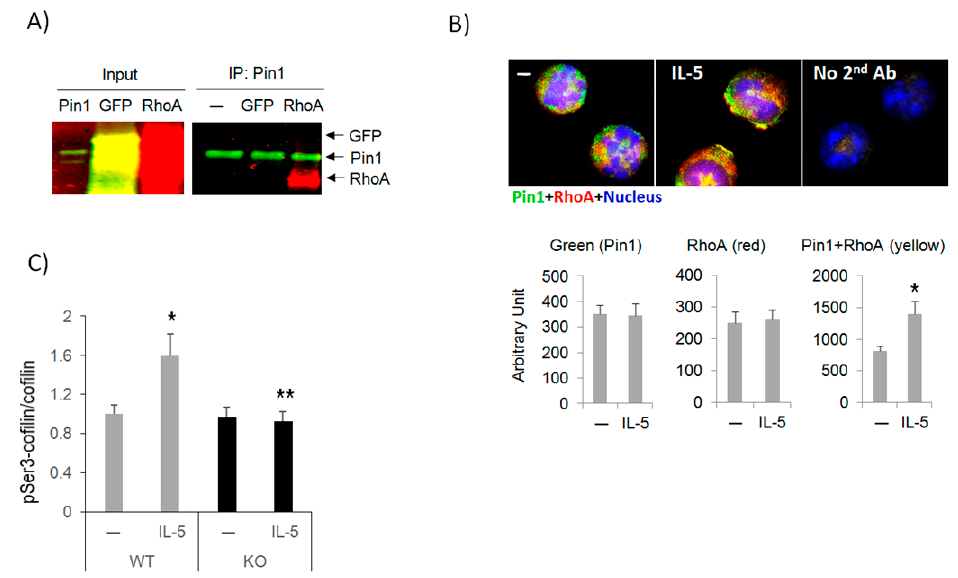
Figure 5. Pin1 interacts with Rho family GTPases and regulates downstream cofilin activity. ( A ) Recombinant proteins were mixed in each condition prior to immunoprecipitation with anti-Myc followed by immunoblot with anti-Pin1 and anti-GFP. ( B ) Human blood Eos were starved for 3 h before treatment with hIL-5 for 10 min. Cytospun cells were co-stained with anti-Pin1 (green), anti-RhoA (red), and DAPI (blue) before examination by fluorescence microscopy and quantification of each color. ( C ) BM-derived mouse Eos were starved for 3 h before treatment with mIL-5 (50 ng/mL). Cells were stained with anti-pSer3-cofilin and anti-cofilin for flow cytometry. Data are from three independent experiments. * p < 0.05 between untreated (–) and IL-5 in WT, ** p < 0.05 between IL-5 treatments.